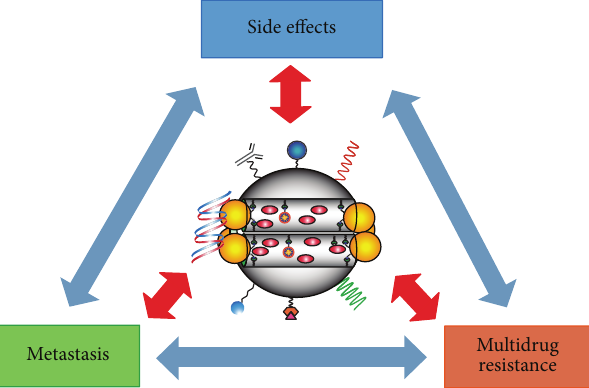
Figure 6: Schematic representation of MSN platform and its interaction with the three main obstacles described in this review for cancer